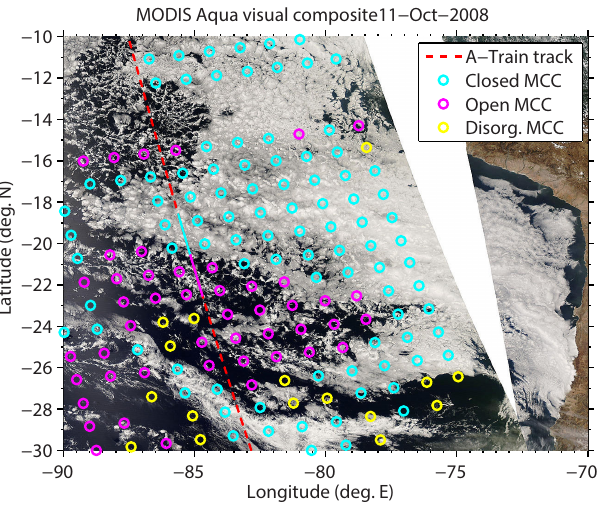
Figure 7. Composite of MODIS Aqua visual imagery for the 11 October 2008 case study in the SEP. Shown are the A-train track (dashed red line) and the MCC types identified by the ANN for each 256 × 256km 2 cloud scene (colored circles) along the MODIS swath. The colored lines mark the sections along the A-train track classified as closed MCC (cyan), open MCC (magenta), and cellular but disorganized MCC (yellow) as an example. The MODIS image resolution is